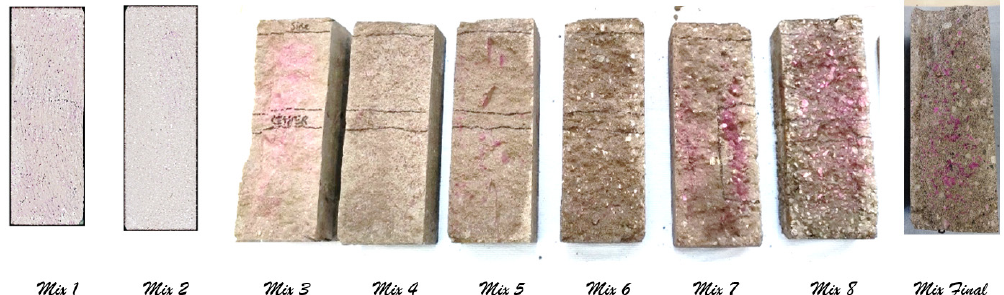
Figure 5. Carbonation fronts identified by phenolphthalein indicator of the mixes. Note that in case of Mix 1 and 2, the samples were cut, while in case of Mix 3 to 8, and the mix final the phenolphthalein indicator test was carried out on the blocks after splitting tensile.